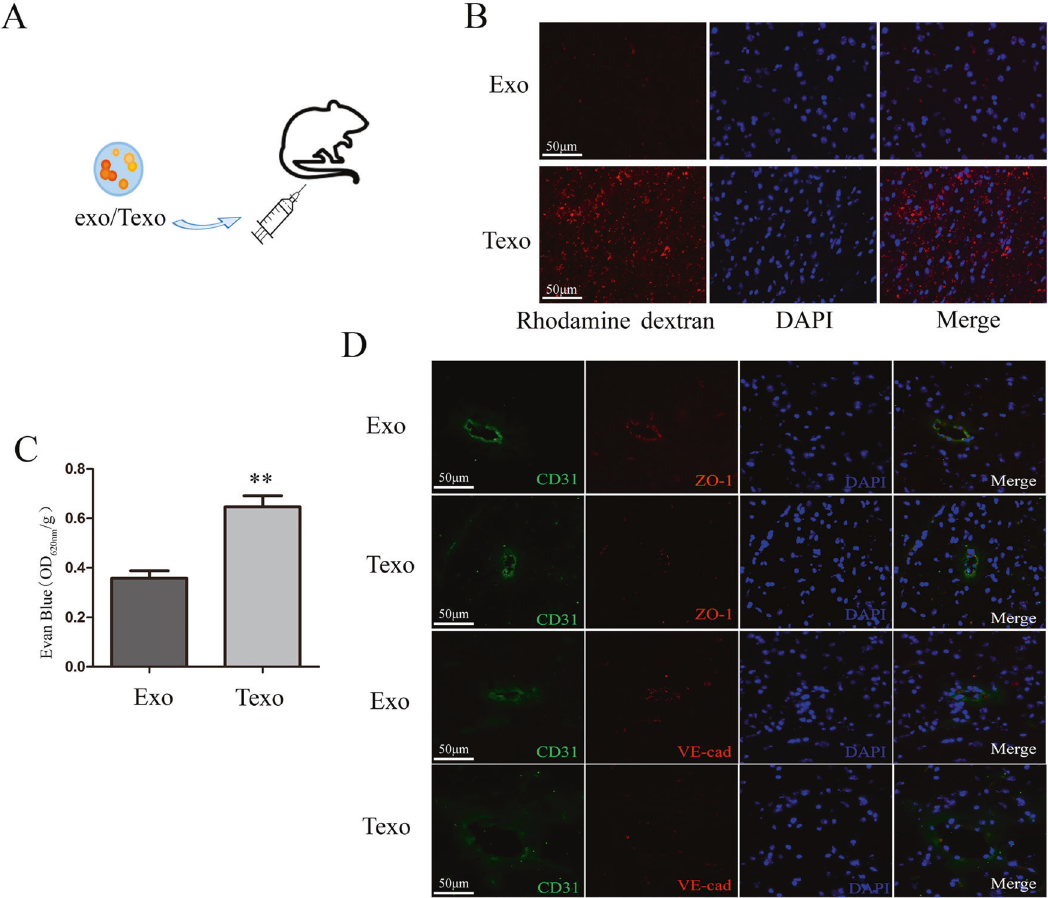
Fig. 2 TGF- β 1-mediated A549-derived exosomes alters the integrity of the BBB in vivo. A Exo or Texo is used for tail vein injection per mouse. B , C Rhodamine B and Evan blue were injected into the mouse tail vein 24 h after exosomes injection. After 3 h of circulation, B in vivo cerebral vascular permeability is determined according to the appearance of intravenously injected rhodamine-dextran (red; scale bar, 50 μ m). C The absorbance of the Evan blue leakage is detected as OD 620nm /g. D Animals are euthanized, and tissues are harvested 27 h after exosomes injection. Brain tissues are subjected to double-label IF for analysis of CD31 (green) and ZO-1 (red) or CD31 (green) and VE-cadherin (red) expression (scale bar, 50 μ m). ** p <